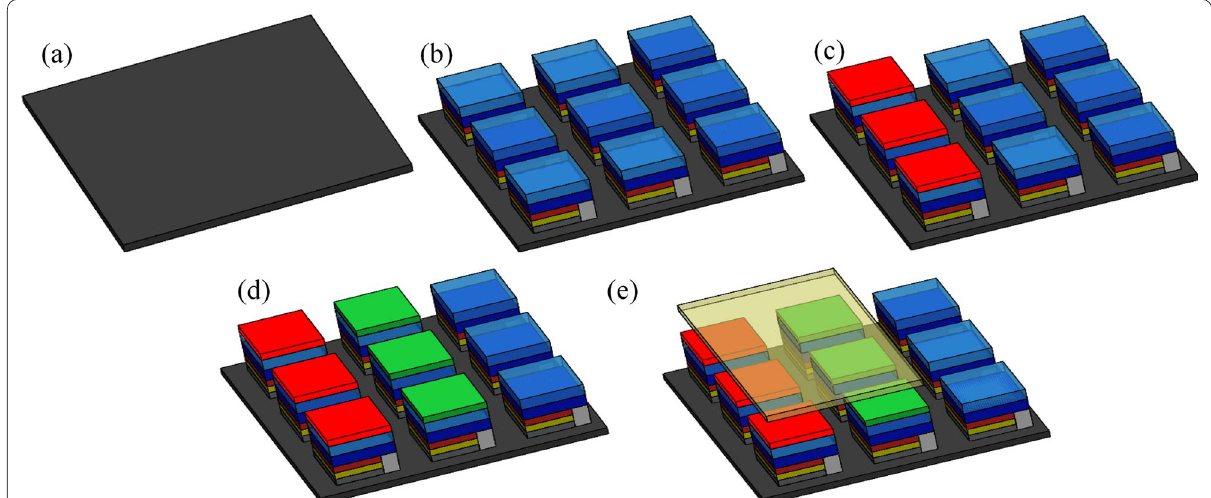
Fig. 5 Structure of high‑color‑purity full‑color micro‑LEDs: a flexible FR4 substrate, b die‑bonding of blue micro‑LEDs on FR‑4, c dispensation of red‑light QDs layer, d dispensation of green‑light QDs layer, e and completion of high‑color‑purity full‑color micro‑LEDs with